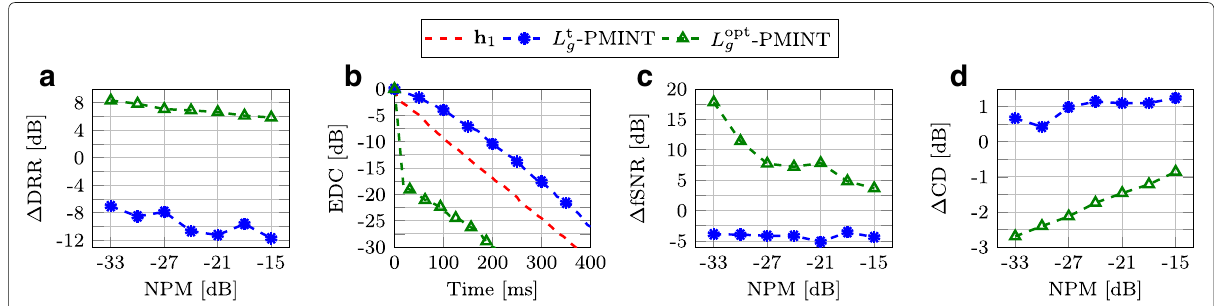
Fig. 7 Performance of PMINT using the conventional filter length L t g and the optimal intrusively determined reshaping filter length L opt g for acoustic system S 1 in terms of a (cid:3) DRR, b EDC for an NPM of − 33 dB, c (cid:3) fSNR, and d (cid:3) CD